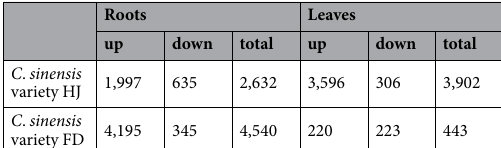
Table 1. The regulation of differentially expressed genes after ammonium treatment. The data show the numbers of DEGs after ammonium treatment compared to the blank control. The definition of DEGs was set as more than a two-fold change in FPKM in the RNA-seq data. The phrase up, down, and total represent up, down, and total regulated expression,